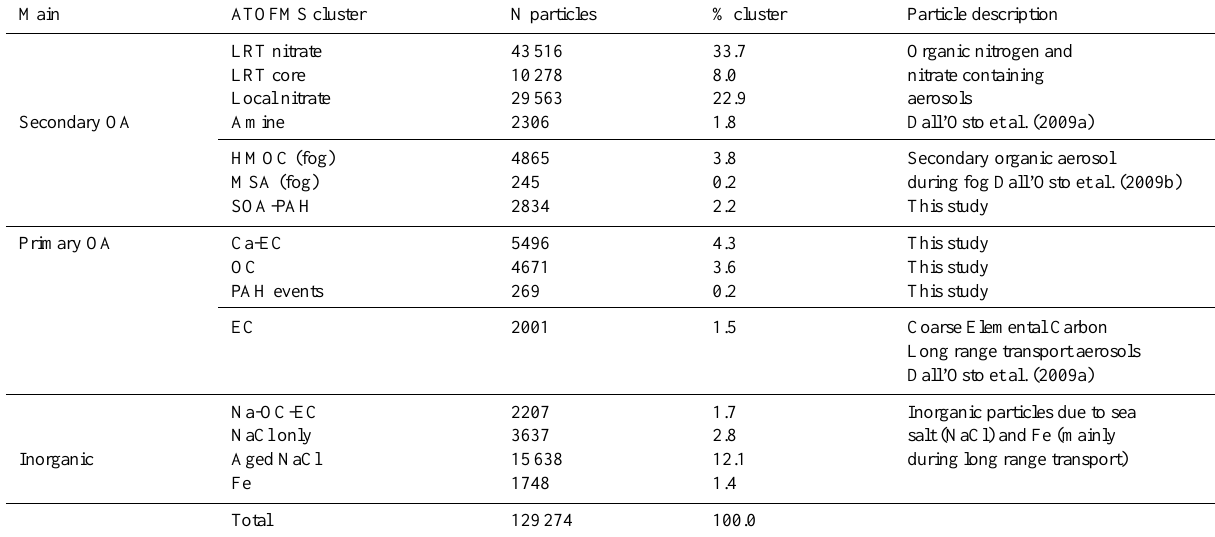
Table 1. ATOFMS particle clusters identified from the REPARTEE campaign. Main ATOFMS cluster N particles %